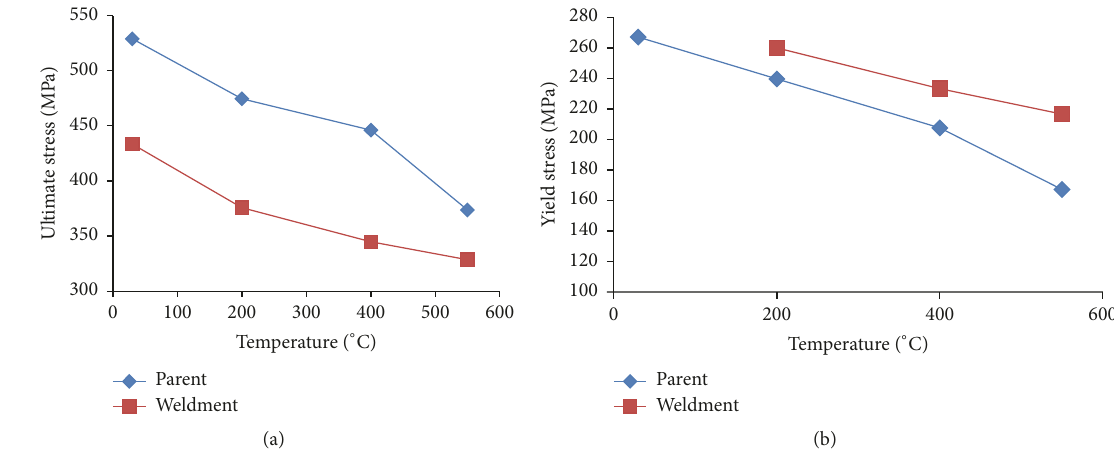
Figure 10: Parent metal and weld metal at different operating temperatures showing (a) UTS and (b) YS.